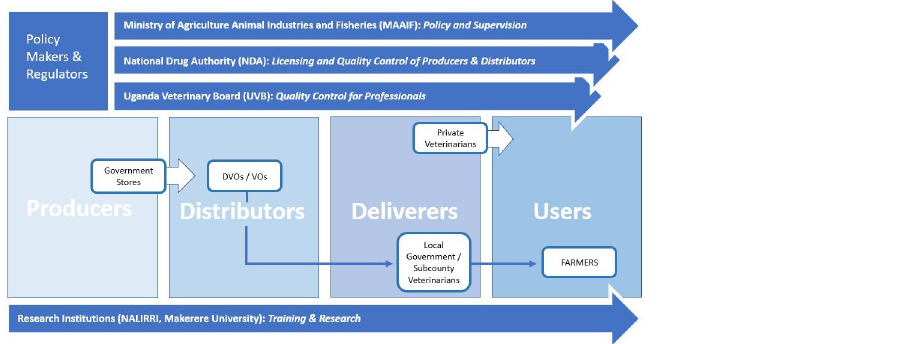
Fig 5. Typical government-led PPR vaccine value